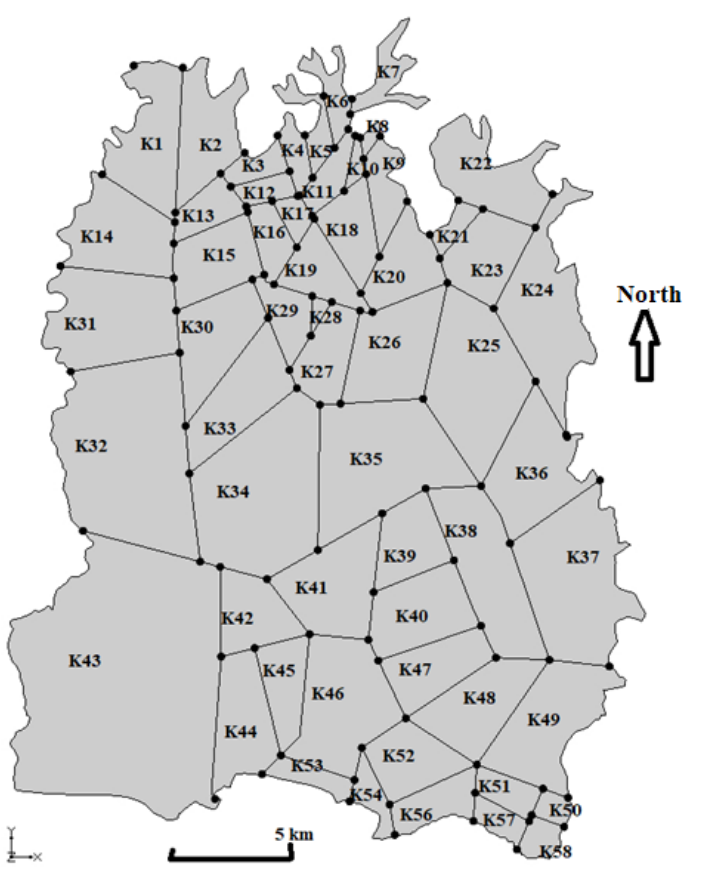
Figure 8. Spatial distribution of the hydraulic conductivity polygons introduced in the model.